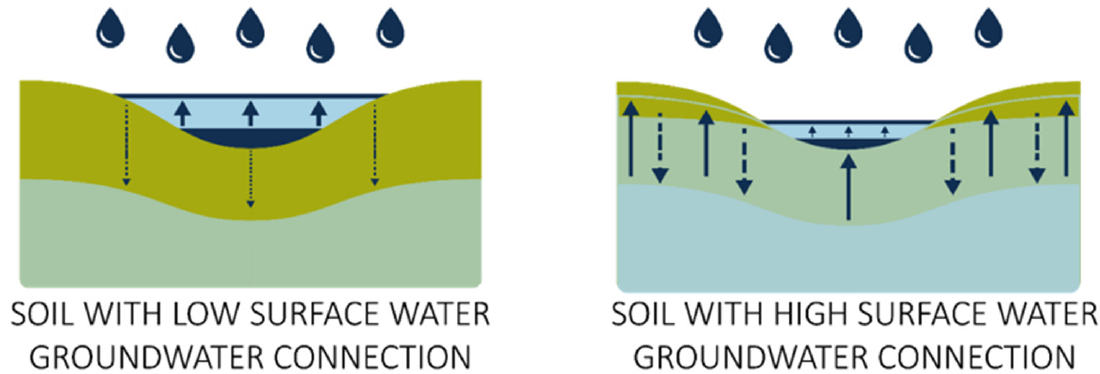
Figure 2. Graphic illustration of slow-onset flood dynamics on the Pampas. The Pampa Deprimida (left) is characterised by low connectivity between the surface water and groundwater, resulting in surface-water-driven pulse floods over the course of weeks or months of excess precipitation. The Pampa Interior, instead, has a high surface water–groundwater connection, which leads to floods as a result of the water table superseding the surface over the course of months or years of excess precipitation to dominate. Nonetheless, Kuppel et al. [17] state that pulse floods can also occur in the Pampa Interior and groundwater floods in the Pampa Deprimida.